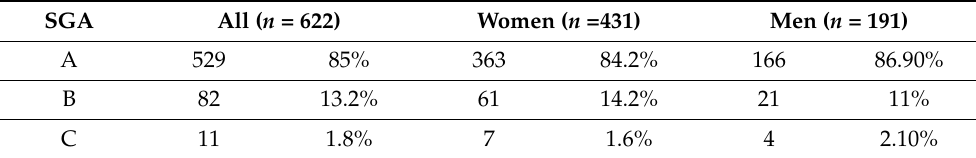
Table 3. SGA distribution.